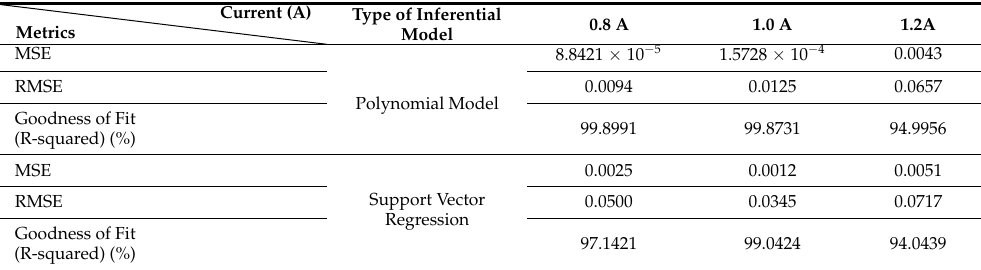
Table 4. Metrics of inferential models at different currents.